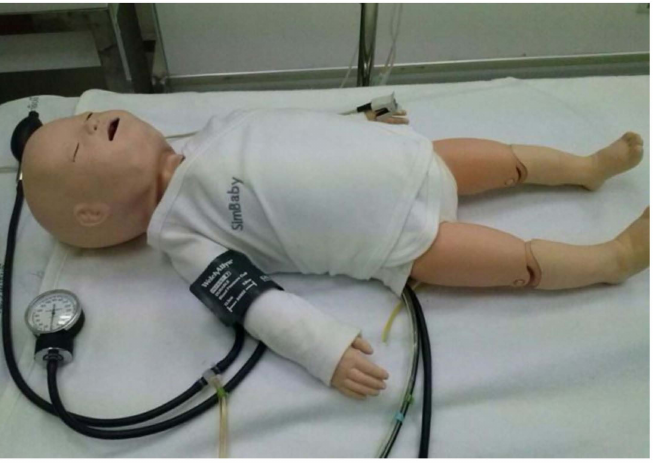
Figure 1. A SimBaby